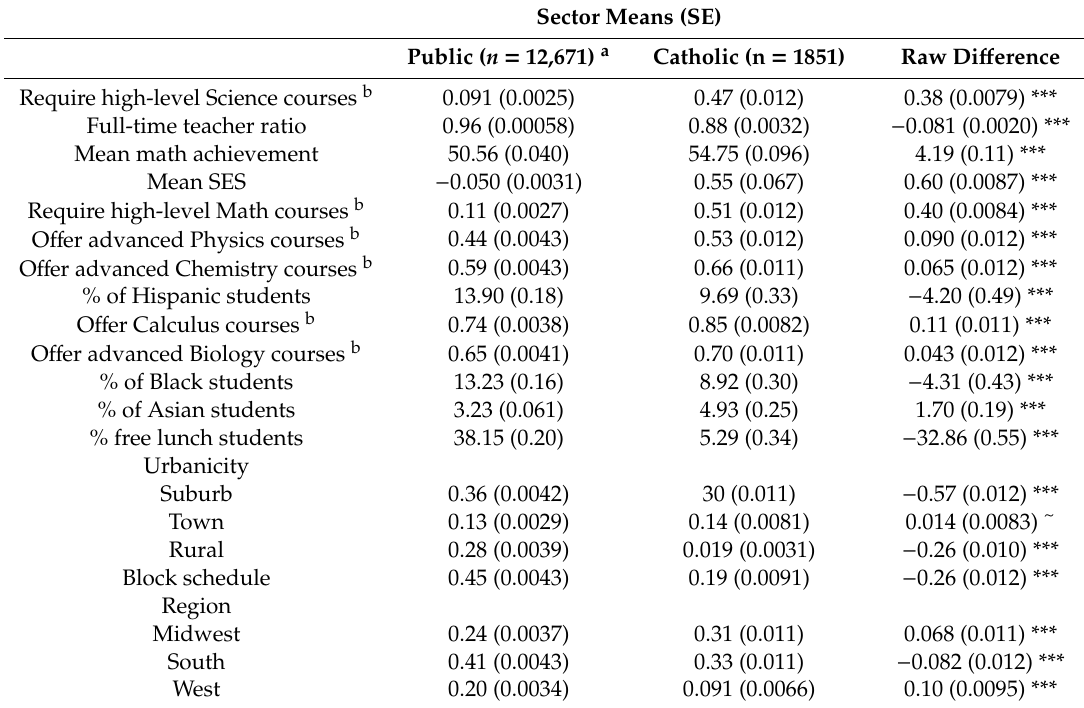
Table 4. Descriptive statistics for school-level